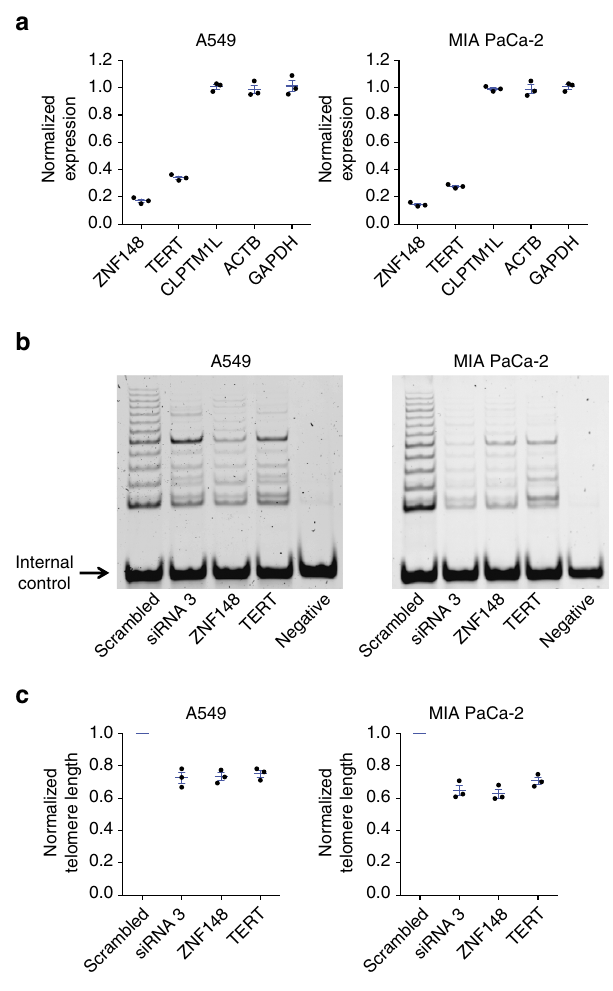
Figure 6 | ZNF148 depletion results in decreased TERT expression and telomerase activity. ( a ) An siRNA directed against the ZNF148 transcript was transfected into A549 (lung, left) and MIA PaCa-2 (pancreas, right) cell lines, and expression of ZNF148 , TERT , CLPTM1L , ACTB and GAPDH were assayed by quantitative PCR. Depletion of ZNF148 resulted in consistent reduction of TERT but not CLPTM1L or control gene expression. Expression values were normalized to those from cells transfected with a scrambled control siRNA. Experiments were conducted in triplicate and repeated three times. Mean measures for three independent experiments are plotted; error bars represent s.e.m. ( b ) siRNAs targeting ZNF148 , TERT , the regulatory region encompassing rs36115365 (siRNA3), or a scrambled siRNA control were transfected into A549 (lung, left) and MIA PaCa-2 (pancreas, right) cell lines, and telomerase activity was measured via a telomeric repeat amplification protocol (TRAP). Negative control represents the TRAP assay performed with no cell extracts added. The internal control represents the 36bp internal standard. ( c ) siRNAs targeting ZNF148 , TERT , or the regulatory region encompassing rs36115365 (siRNA3) were transfected into A549 (lung, left) and MIA PaCa-2 (pancreas, right) cell lines repeatedly (once every four days), and telomere length was measured after 20 days using quantitative PCR for telomere repeat copy number. Data are normalized to those from a scrambled siRNA control. Experiments were conducted in triplicate and repeated three times. Mean measures for three independent experiments are plotted; error bars represent